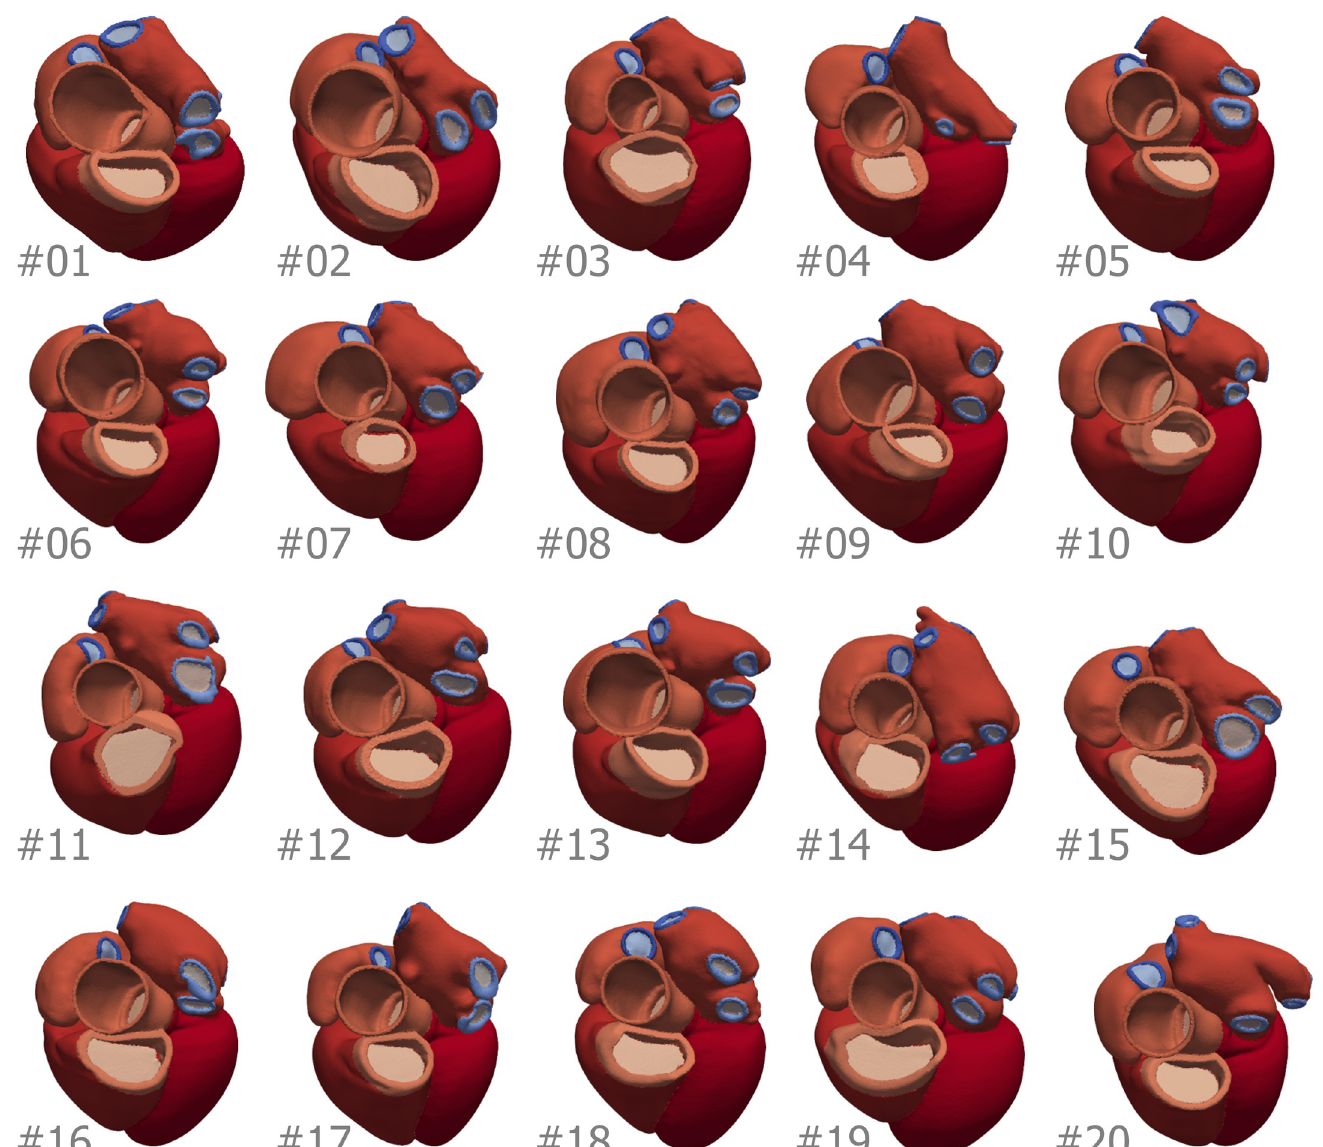
Fig 2. Meshes of the 20 cases of the CT cohort, with the number of the case in the bottom left corner of each image. Colour indicate mesh labels described in S1 Text and referenced in the tables in S5 Text. For the SSM construction we discarded mesh